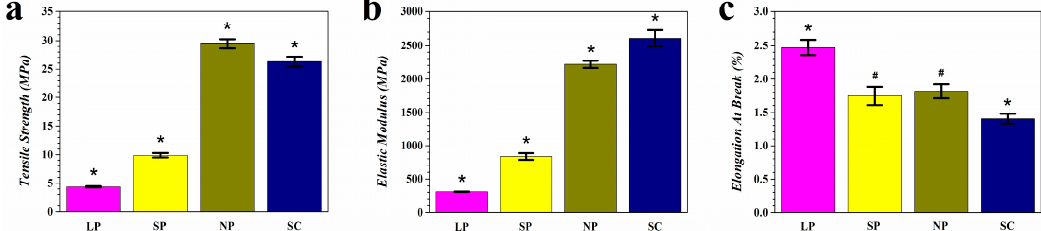
Figure 4. Results of the tensile test. ( a ) Tensile strength; ( b ) Elastic modulus; and ( c ) Elongation at break. ( n = 5; * p < 0.05 compared to all other groups, # p < 0.05 compared to LP and SC groups).